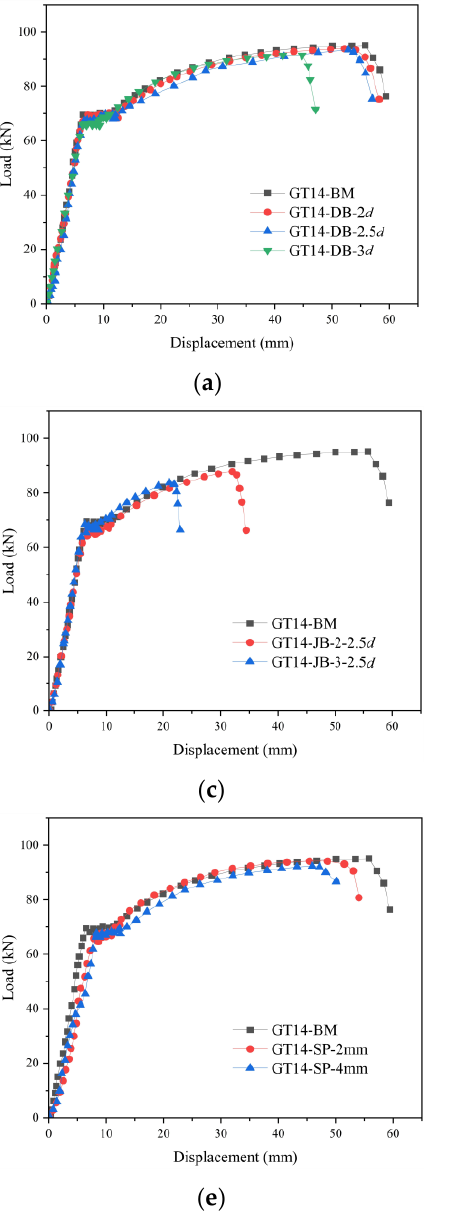
Figure 12. Load – displacement curves. ( a ) GT14-BM + GT14-DB. ( b ) GT14-BM + GT14-ZB. ( c ) GT14-BM + GT14-JB. ( d ) GT14-BM + GT14-DC. ( e ) GT14-BM + GT14-SP. ( f ) Comparison between curves.